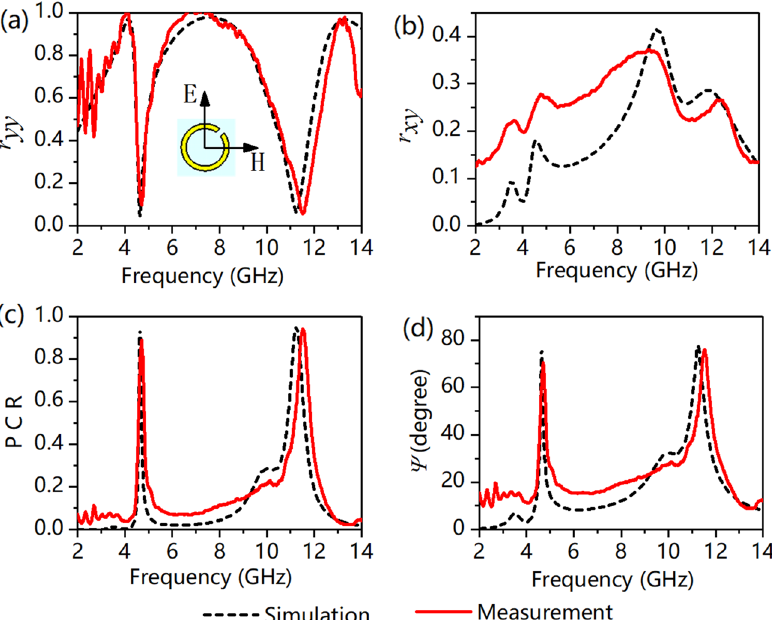
Figure 5. Results of reflected waves under a y-polarized incident wave. The inset of ( a ) depicts the orientation of the fields with respect to the structure, i.e., the directions of the H-field and E-field along the x- and y-axes, respectively. ( a ) Copolarization reflectance of r yy , ( b ) cross-polarization reflectance of r xy , ( c ) polarization conversion ratio (PCR), and ( d ) polarization rotation angle of Ψ .